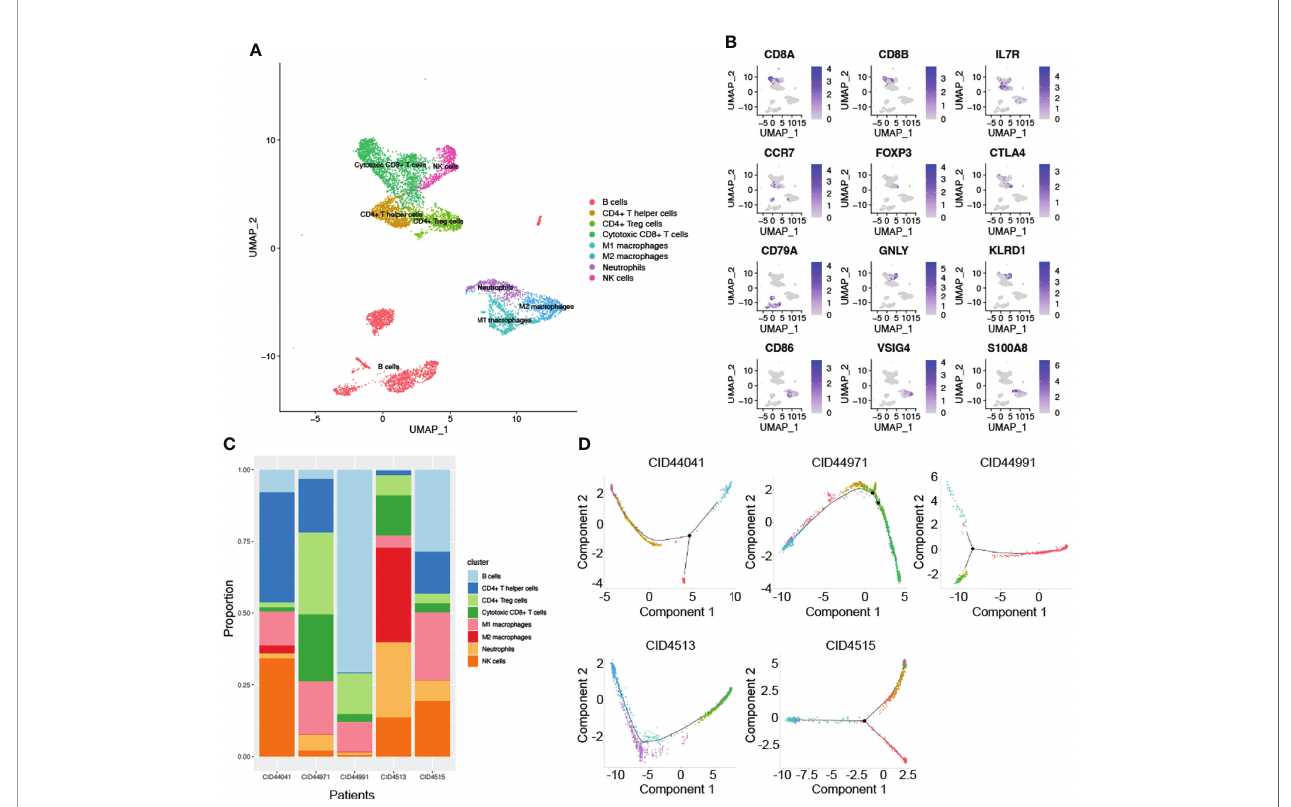
FIGURE 2 | The complex composition of the tumor immune microenvironment. (A) Combining singleR and canonical marker, we successfully annotated 8 immune cell clusters, including B cells, CD4 + T helper cells, CD4 + Treg cells, cytotoxic CD8 + T cells, NK cells, neutrophils, M1 and M2 macrophages. (B) Representative marker genes were shown using non-linear dimensional reduction (B cells: CD79A, CD4+ T helper cells: IL7R and CCR7, NK cells: GNLY and KLRD1, M1 macrophages: CD86, neutrophils: S100A8, CD4+ Treg cells: FOXP3 and CTLA4, and M2 macrophages: CD163 and VSIG4). (C) All annotated immune cell clusters were estimated in each patients, with varying proportions of cell types between cases. (D) Pseudotime analysis was used to construct the trajectory of immune cells